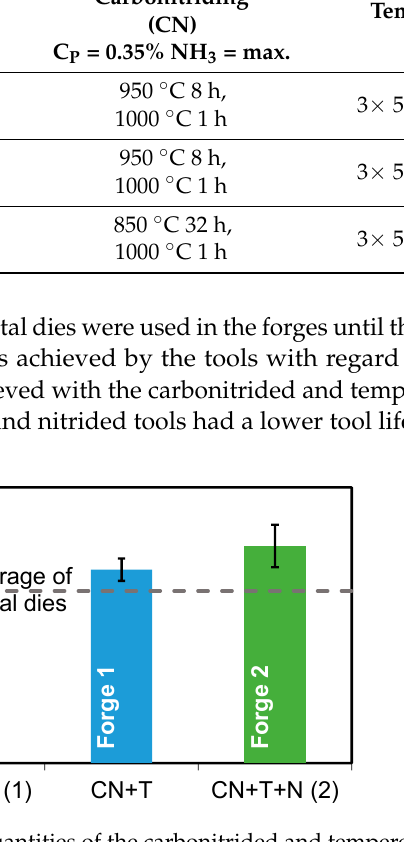
Table 5. Heat treatment parameters for the experimental forging dies.